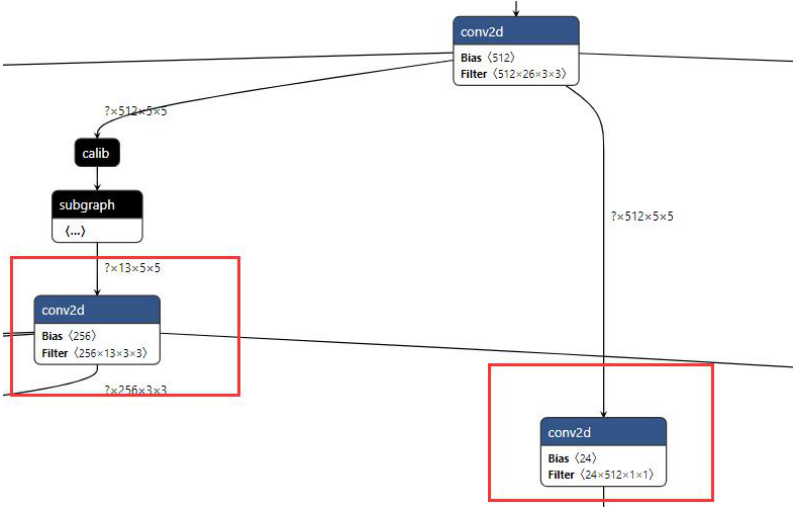
Figure 9. Comparison before and after subgraph